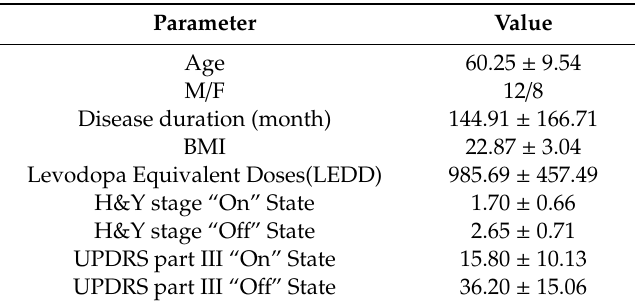
Table 2. Demographics of Parkinson’s disease (PD) Patients.